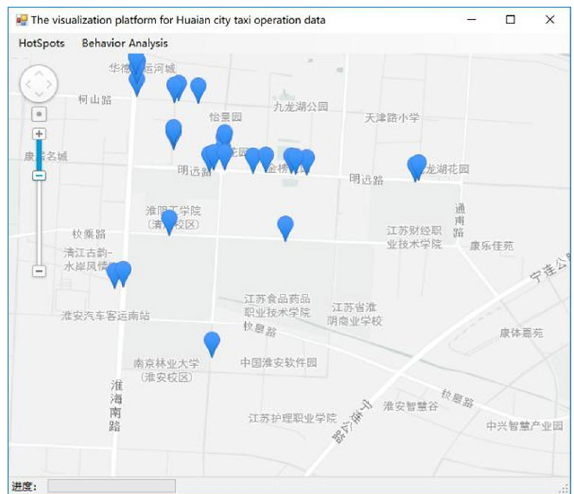
Figure 8. The diagram of passenger hotspot map 28 .